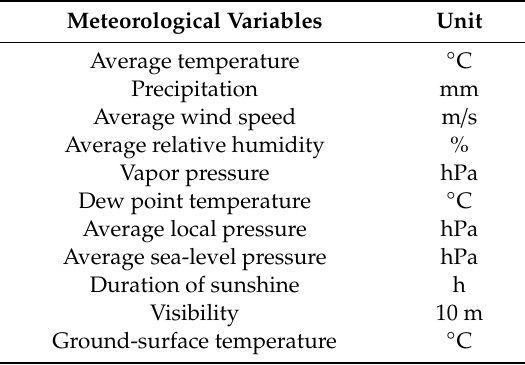
Table 3. Used meteorological variables.